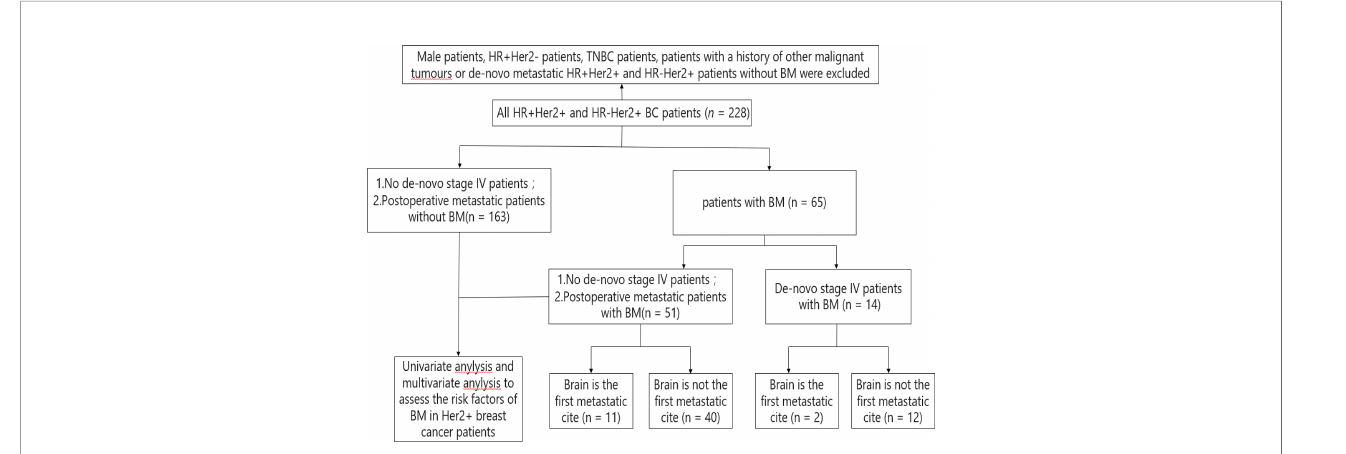
FIGURE 1 | Constitution of the study population. BC, breast cancer; BM, brain metastasis; HR, hormone receptor; HR+, HR positive; HR-, HR negative; Her2, human epidermal growth factor receptor 2; Her2+, Her2 positive; Her2-, Her2 negative; TNBC, triple negative breast